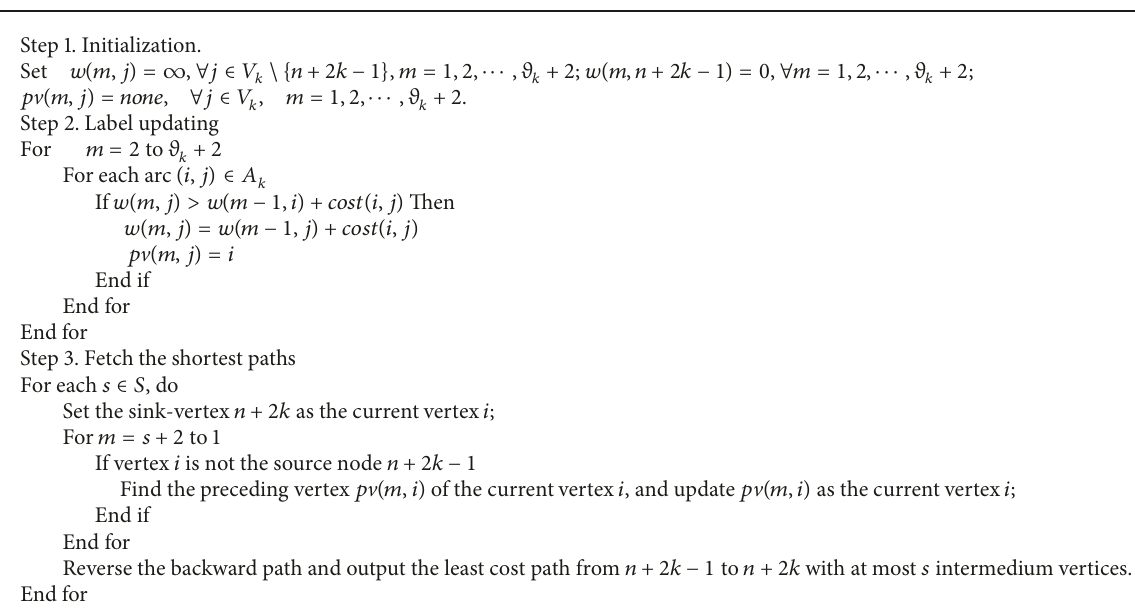
Algorithm 1: The shortest path algorithm with vertices constrained in 𝐺 𝑘 .